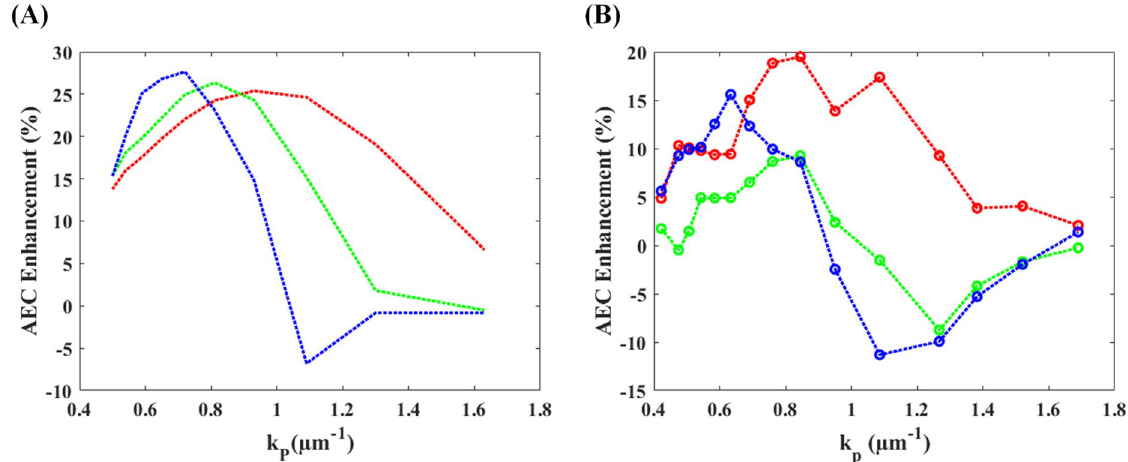
Figure 3. AEC enhancement of structured light patterns with different spatial frequencies and orientations: ( A ) simulation results and ( B ) experimental results. Note that each figure shows three orientations of the modulated light pattern, i.e., 0° (red), 45° (green), and 90°